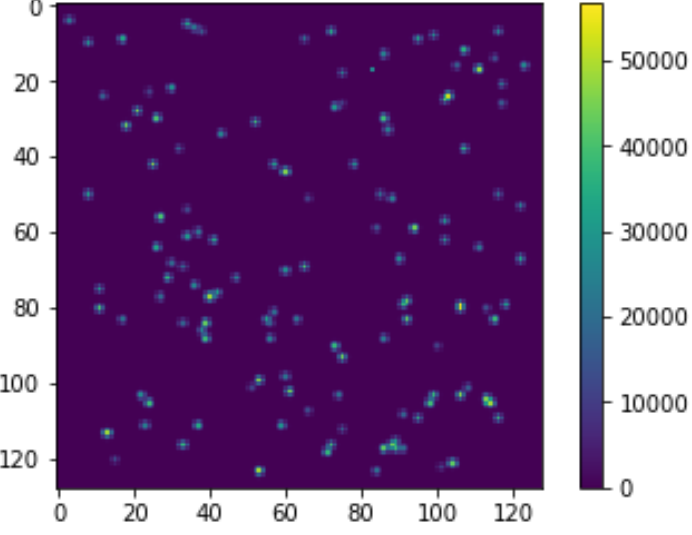
Figure 3. Sample observed image.